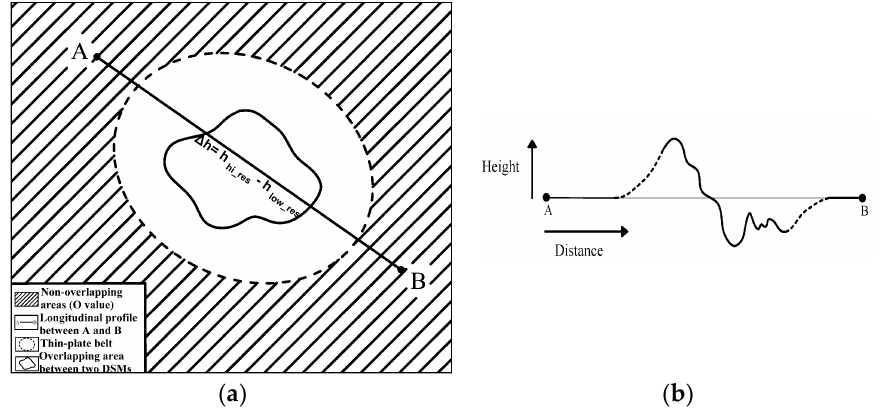
Figure 6. DSM blending: ( a ) Concept of asymmetric DSM blending method; ( b ) longitudinal profile between A and B.